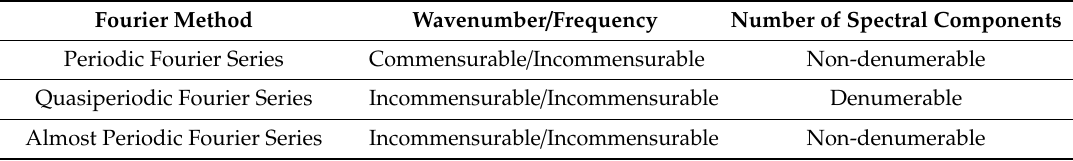
Table A1. Characteristics of the Di ff erent Methods of Fourier